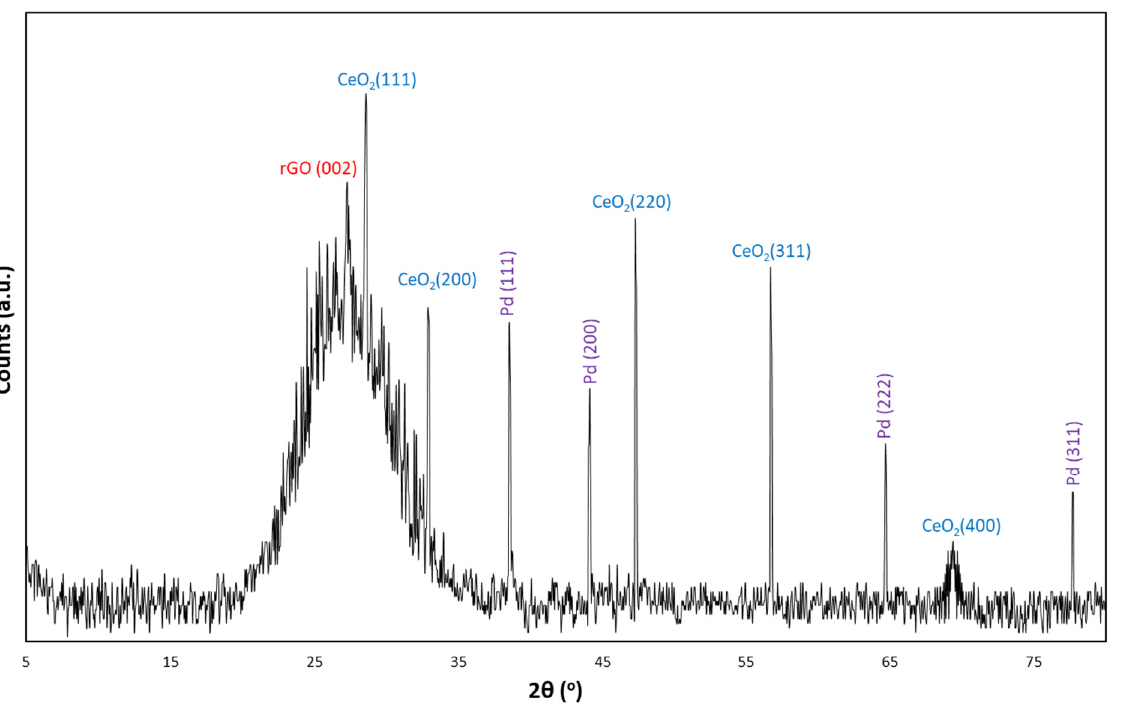
Figure 4. X-ray analysis of CeO 2 -Pd-PDA/rGO heterojunction nanocomposite. From the XRD pattern, the high-intensity diffraction peaks observed at 2 θ = 28.6, 32.9, 47.3, 56.7, and 69.4 attributed to the (111), (200), (220), (311), and (400) crystalline planes of CeO 2 , respectively, which was a very good fit with the JCPDS data card No. 43-1002 [35]. The results confirm the hexagonal structure of the CeO 2 , which is consistent with the HRTEM results that are presented later in this section. The other sharp peaks at 2 θ = 38.55, 44.15, 64.7, and 77.7 are attributed to the (111), (200), (222), and (311) lattice planes of Pd NPs, respectively, which are a good fit to the JCPDS DATA CARD No. 5-681. This result indicates the face-centred cubic (FCC) structure of the Pd NPs inside the rGO NSs [33]. Hydrogen adsorption selectivity of the sensing material is highly correlated to the morphology-dependent oxygen reducibility and oxygen vacancy concentrations [56]. Given that, different morphologies of CeO 2 possess unique catalytic behaviour corresponding to the specific surface characteristics of each particular lattice plane [57,58]. For instance, the predominant (111) crystal plane is responsible for the selective hydrogenation reaction due to the lowest surface energy and highest oxygen vacancy concentration [59]. In addition, the H 2 molecules occupying the oxygen vacancies on the sensor’s surface can